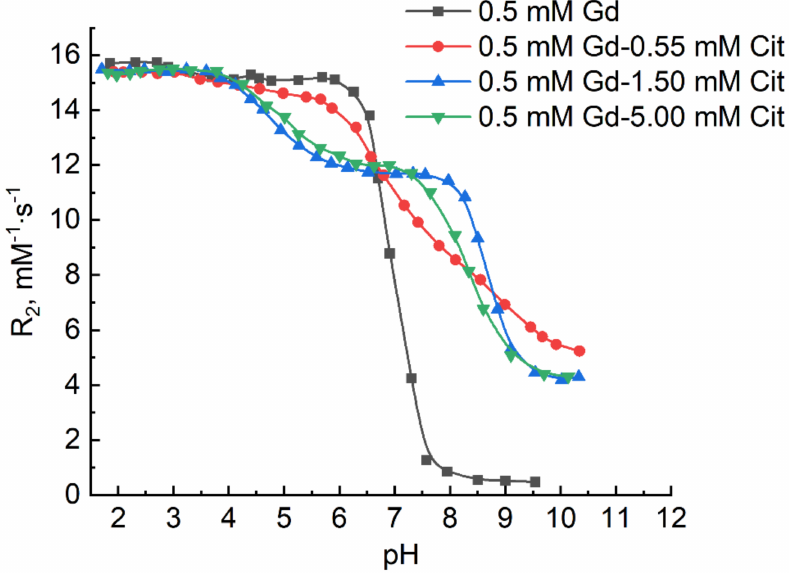
Figure 1. Variation of R 2 values at different pH values of the solutions of Gd 3+ ions and its complexes with citric acid in water. C Gd(III) 0.5 mM, C H4L 0–5 mM, C PEI 10 mM.